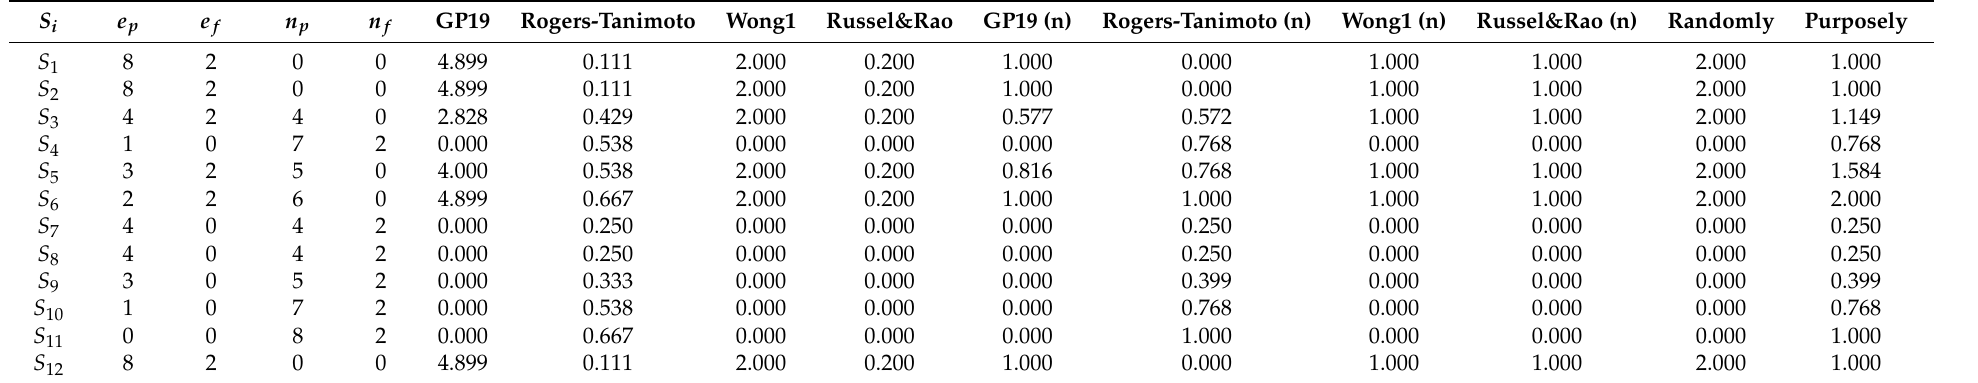
Table 3. Example of the MinMaxScaler values from scikitlearn. The (n) signifies the normalized